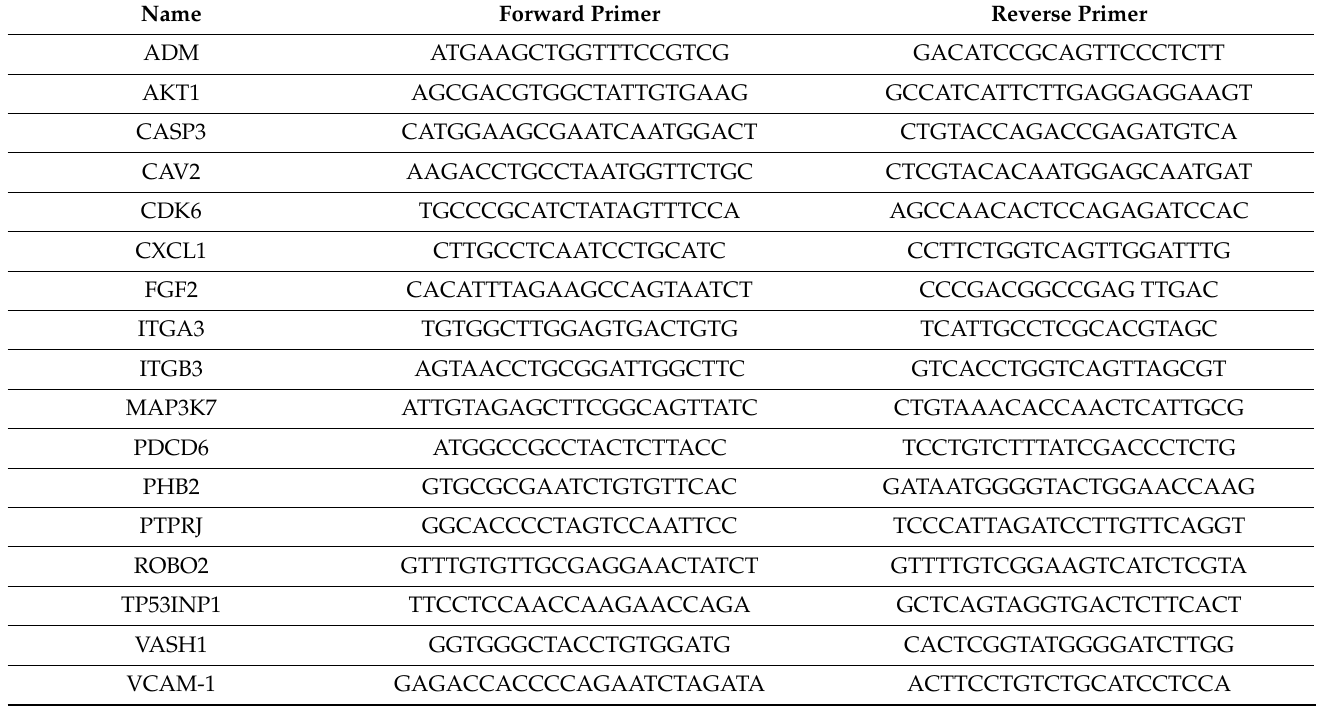
Table 2. Sequences of the primers used for the qPCR. All primers were synthesized by IDT-DNA. ADM: adr é nom é dulline, AKT1: AKT serine/threonine kinase 1, CASP3: caspase 3, CAV2: cav é